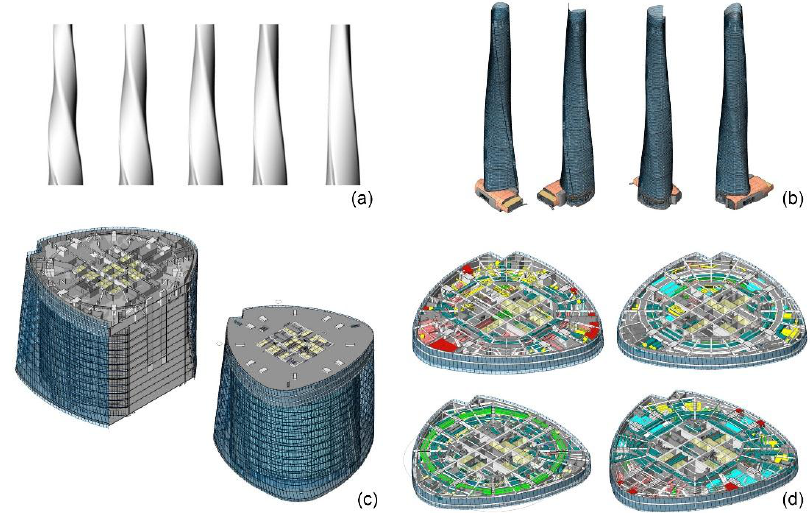
Figure 1. ( a – d ) An example to represent the different Level Of Development (LODt) of Trade Center building from 100 to 400, respectively.